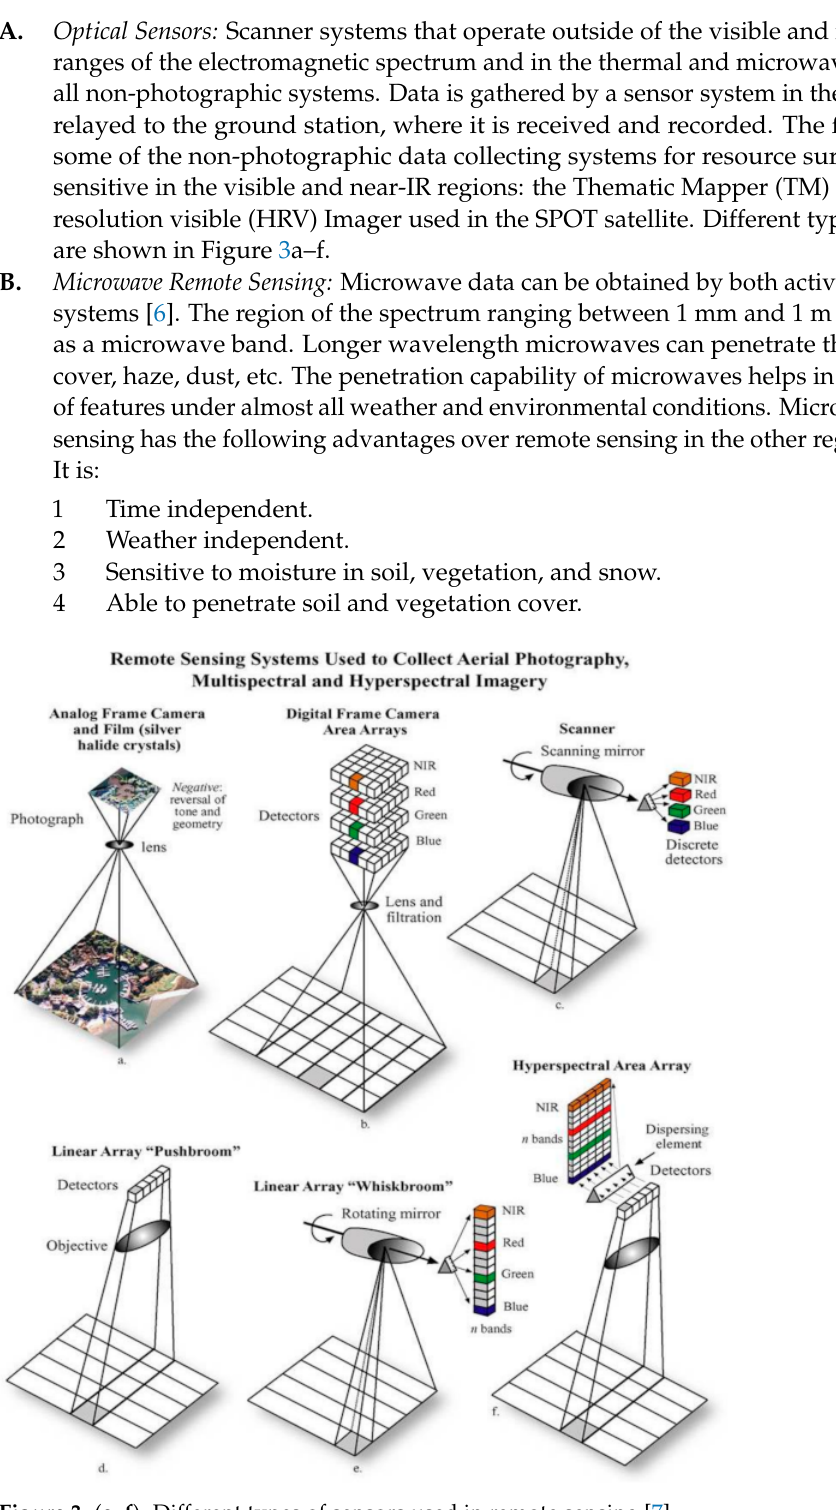
Figure 3. ( a – f ). Different types of sensors used in remote sensing [7]. Microwave remote sensing is divided into two types. Thermal remote sensing is analogous to passive microwave sensing. Within its area of vision, passive microwave sensors detect naturally released microwave energy. It reacts to extremely low levels of microwave energy emitted/reflected by landscape features from ambient sources. Such sensors are used in meteorology, hydrology, and